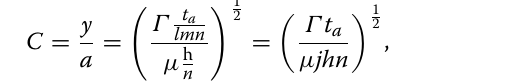
number of printing raster to number of layers, printing surface tension are assumed to be constant in this study.